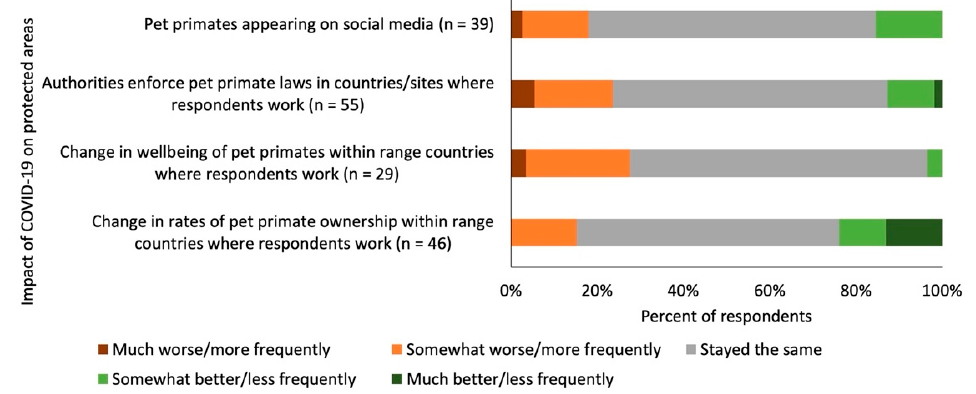
Figure 4. Opinions given by respondents on the how the COVID-19 pandemic had affected different aspects of pet primate ownership in sites and countries where they worked.